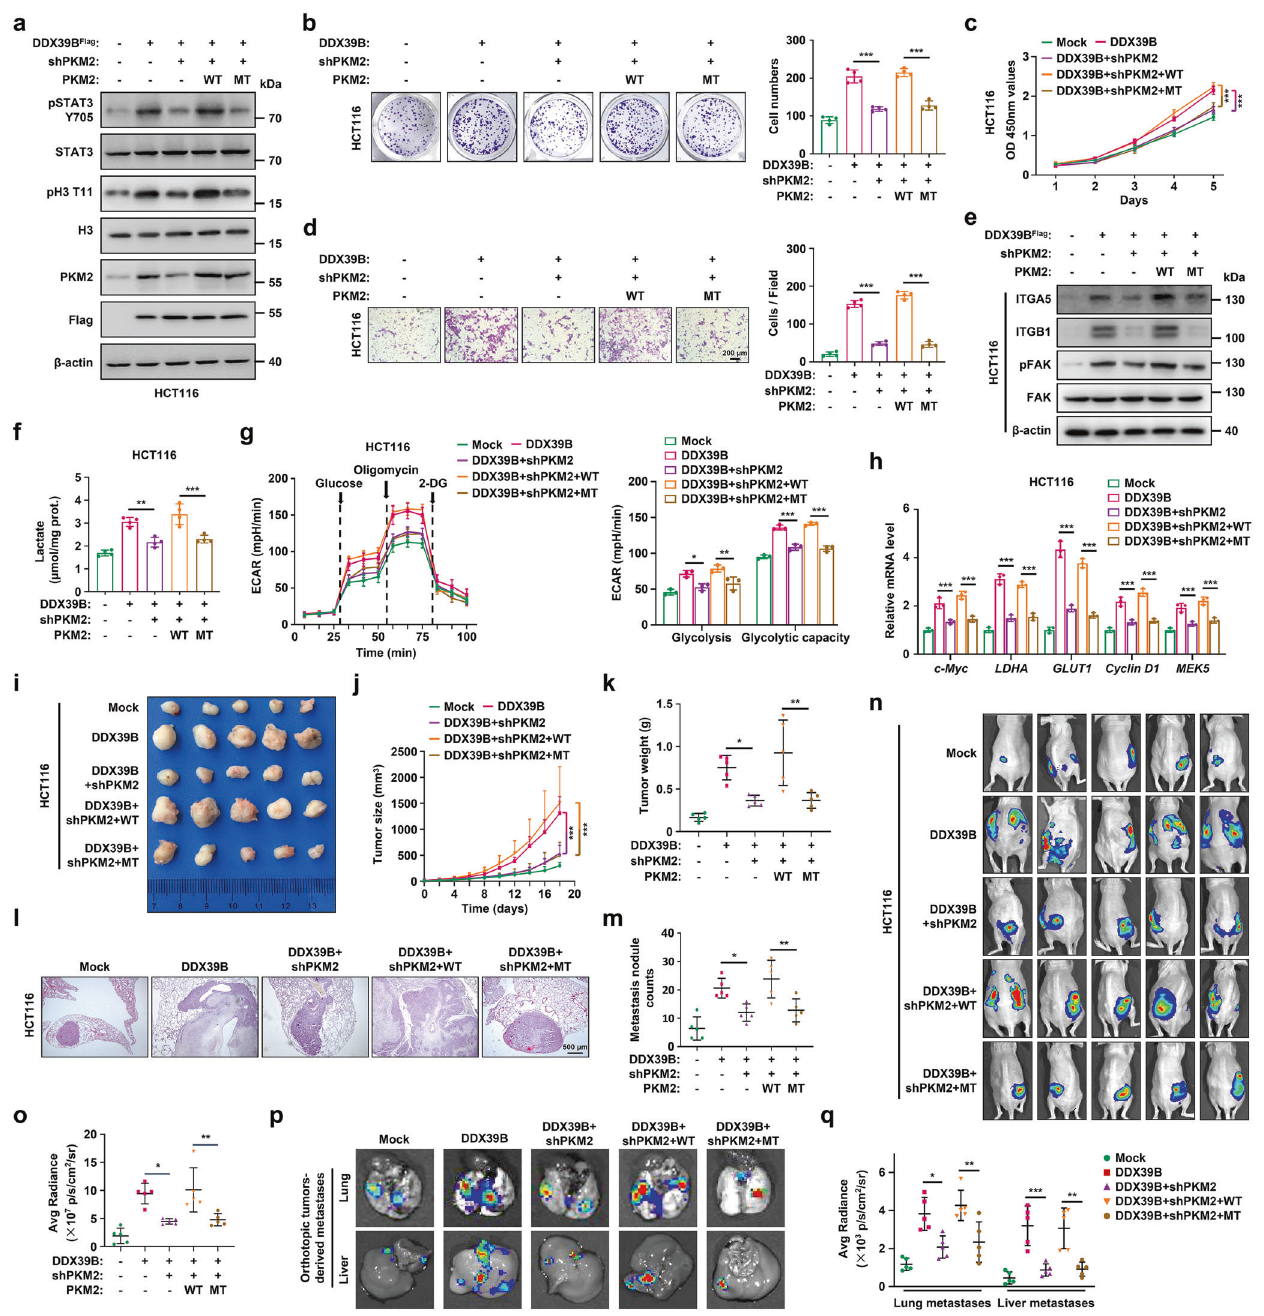
Fig. 8 Blocking PKM2 nuclear accumulation impairs DDX39B-triggered Warburg effect and tumorigenicity in CRC. a – q HCT116 cells simultaneously expressing DDX39B cDNA and PKM2-shRNA were re-introduced into RNAi-resistant PKM2 WT or PKM2 R399/400A mutant (MT), respectively. a Phosphorylation of STAT3 Y705 and histone H3 T11 was detected by western blotting. b The cell proliferation was measured by colony formation assay. c Cell viability was measured by CCK8 assay. d Cell motility was determined by transwell migration assays. e The indicated protein levels were detected by western blotting. f The lactate production in indicated HCT116 cells was quanti fi ed. g The extracellular acidi fi cation rate (ECAR) of indicated HCT116 cells was monitored, and the levels of glycolysis and glycolytic capacity were calculated. h The relative transcriptions of c-Myc, GLUT1, LDHA, Cyclin D1 and MEK5 were measured by qPCR. The growth and metastatic abilities of indicated HCT116 cells in vivo were assessed in nude mice by subcutaneous and lung metastasis tumor models ( n = 5), respectively. The images ( i ), tumor sizes ( j ), and tumor weights ( k ) of subcutaneous xenografts are presented. Representative pulmonary metastases detected by H&E staining are shown ( l ), along with the number of metastatic nodules ( m ). n – q Indicated HCT116 cells were orthotopically inoculated into the cecum of mice ( n = 5). At day 60 after inoculation, the bioluminescent images of orthotopic tumors were captured ( n ) and light emissions were quanti fi ed ( o ). The representative bioluminescent images of the isolated lungs and livers were obtained ( p ), and the metastases were quanti fi ed ( q ). Data are presented as mean ± SD. The p values were obtained by two-way ANOVA ( c, j ) or one-way ANOVA (others). * p < 0.05, ** p < 0.01, *** p < 0.001